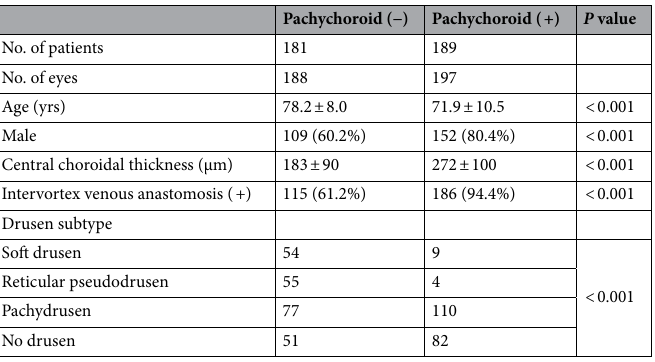
Table 2. Comparison between neovascular age-related macular degeneration with and without